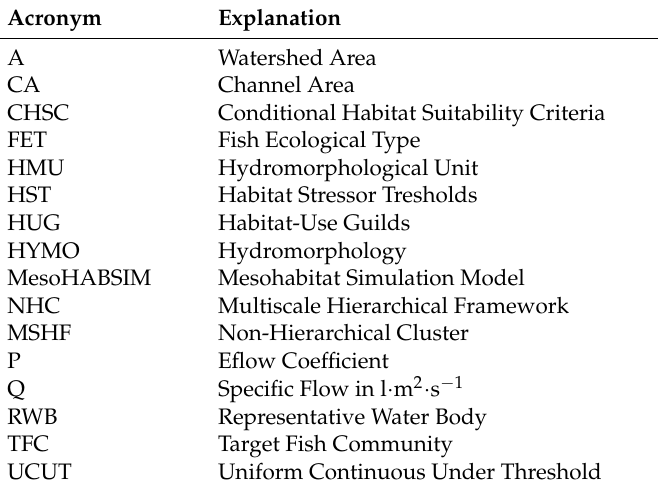
Table 1. List of acronyms